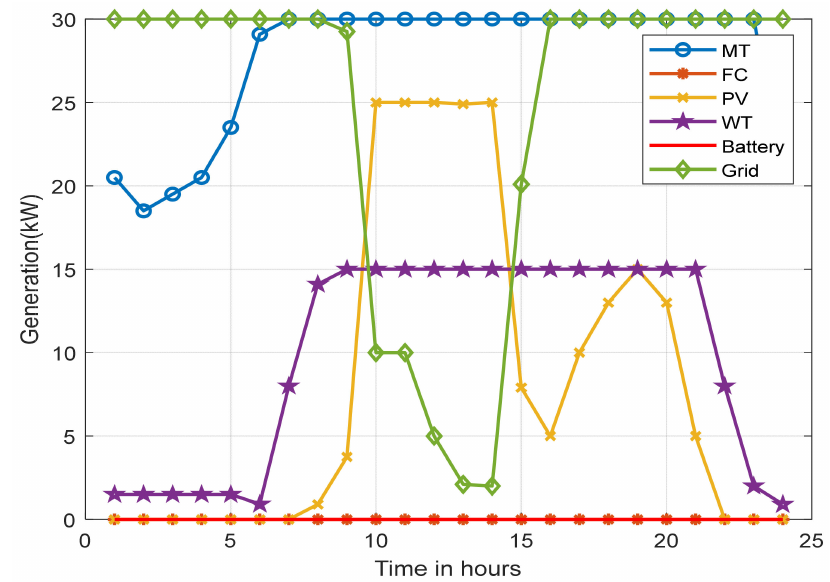
Figure 13. Power generation for Scenario